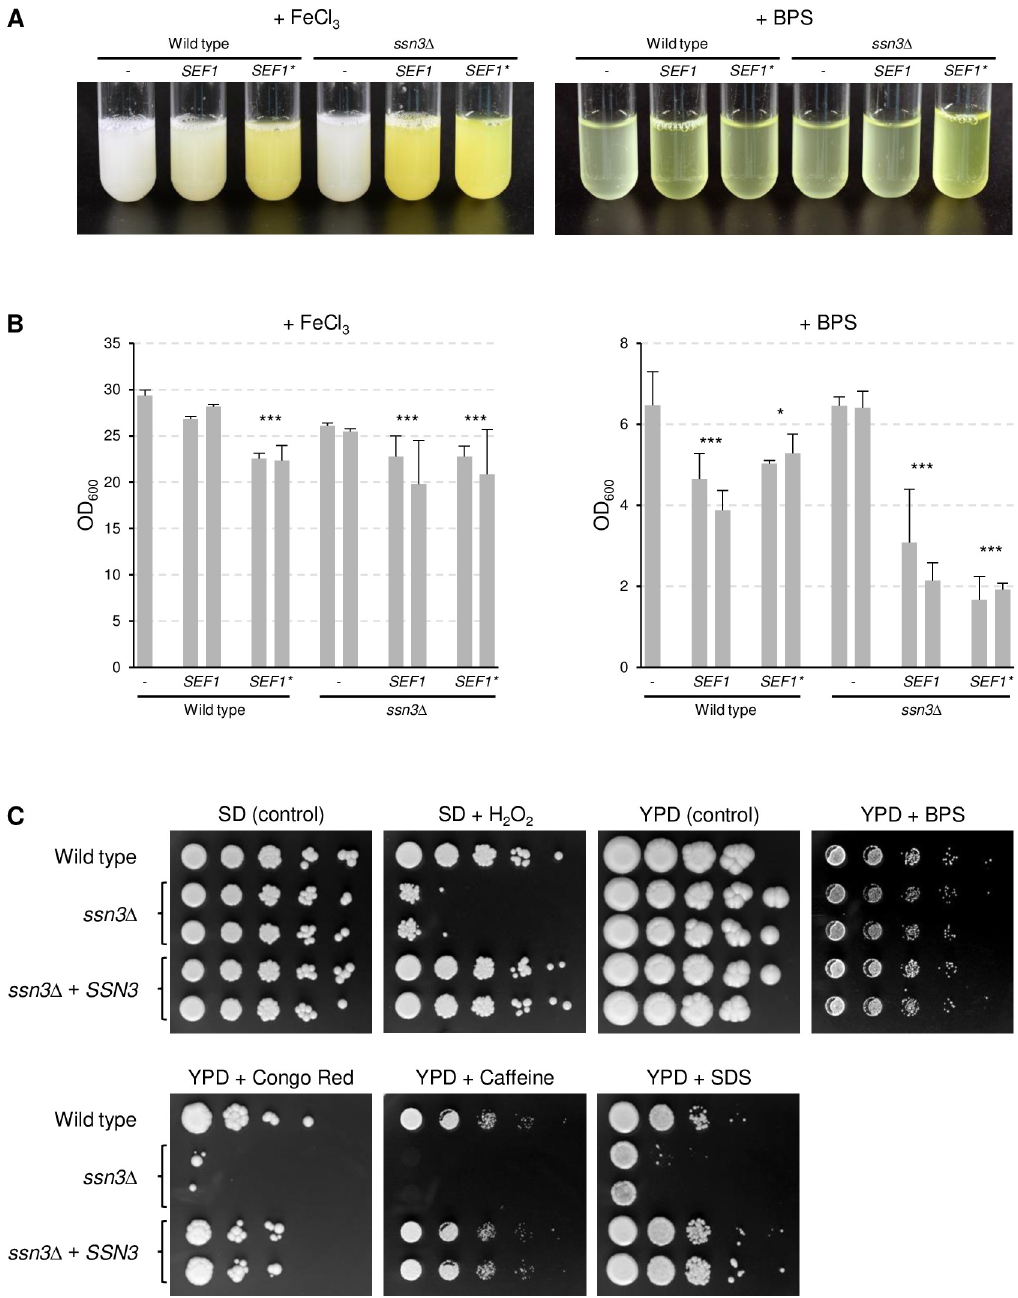
Fig 1. Ssn3 is not required for Sef1-induced riboflavin secretion and growth under iron-limiting conditions. (A) The wild- type strain SC5314, ssn3 Δ mutants, and derivatives overexpressing wild-type SEF1 or the hyperactive SEF1 � were grown in minimal medium with (+ FeCl 3 ) or without iron (+ BPS). Cultures were photographed after 4 days of growth at 30˚C. The two independently generated series of strains behaved identically and only one of them is shown. Removal of the cells by centrifugation (not shown) demonstrated that the yellow riboflavin was secreted into the supernatant. (B) The optical densities of the cultures were determined; shown are the means and standard deviations of three independent cultures of each strain. Results for both independently generated series of strains are shown separately; data were combined for statistical analysis. Significant differences from the wild type are indicated by stars ( ��� , p < 0.001; � , p < 0.05). (C) Stress sensitivity of the wild- type strain SC5314, ssn3 Δ mutants, and complemented strains. YPD overnight cultures of the strains were serially 10-fold diluted, spotted on the indicated agar plates, and grown for 4 days at 30˚C. Both series of mutants are shown.